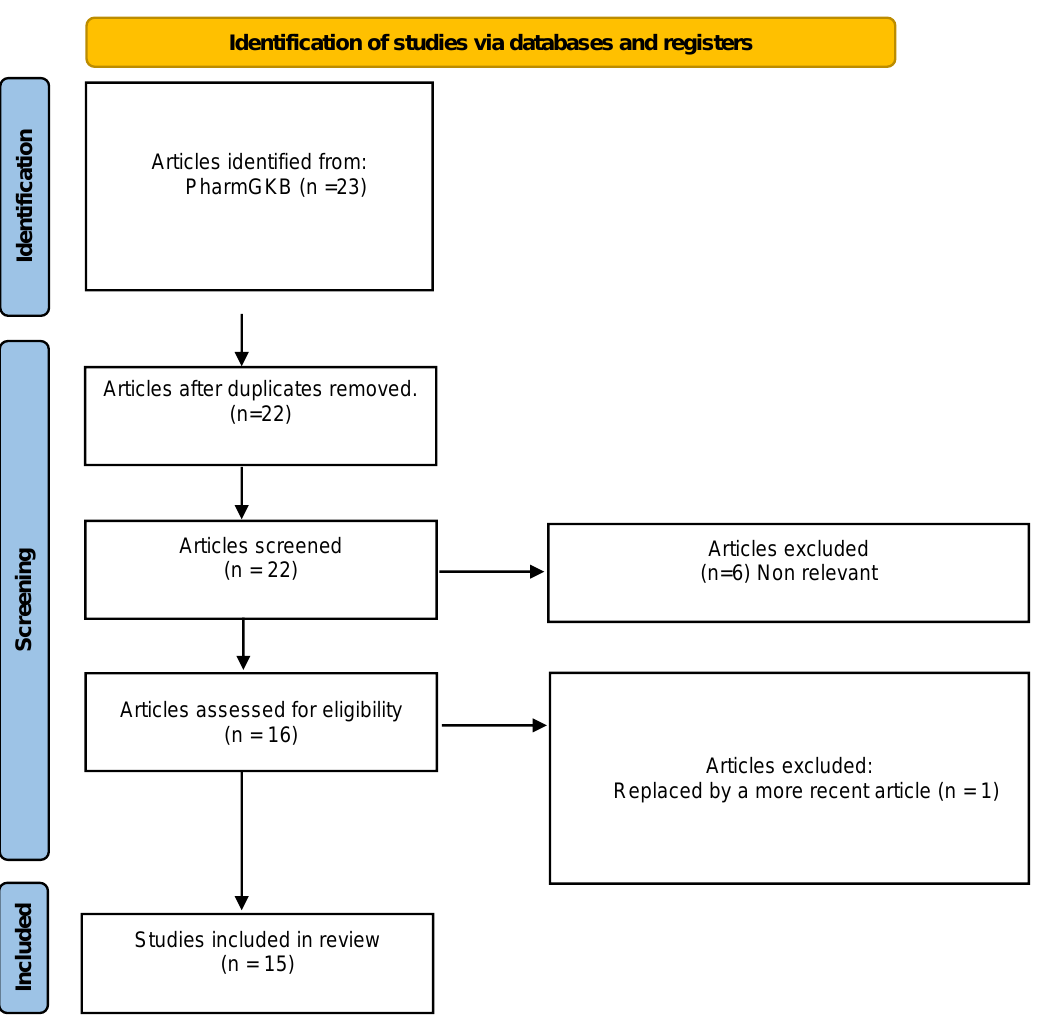
Figure 2. PRISMA flow chart of studies identified, screened, assessed for eligibility and included in this traditional review.